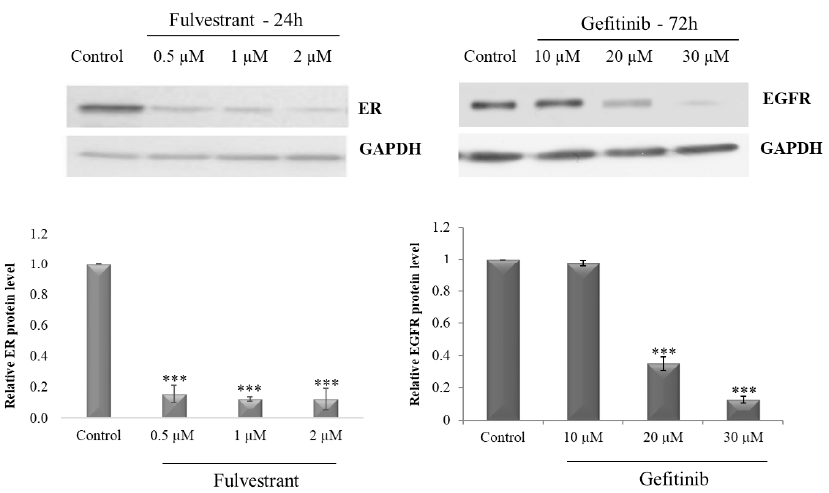
Figure 1. Immunoidentification of estrogen and epidermal growth factor receptors after treatment of studied breast cancer cells with different concentrations of specific receptor blockers in MCF7 and MDA-MB-231 cells. MCF7 cells were treated with fulvestrant in the concentration range 0.5–2 µ M for 24 h and MDA-MB-231 cells were treated with gefitinib for 72 h in the concentration range 10–30 µ M. GAPDH was used as a loading control. *** p < 0.01, relative to control cells.